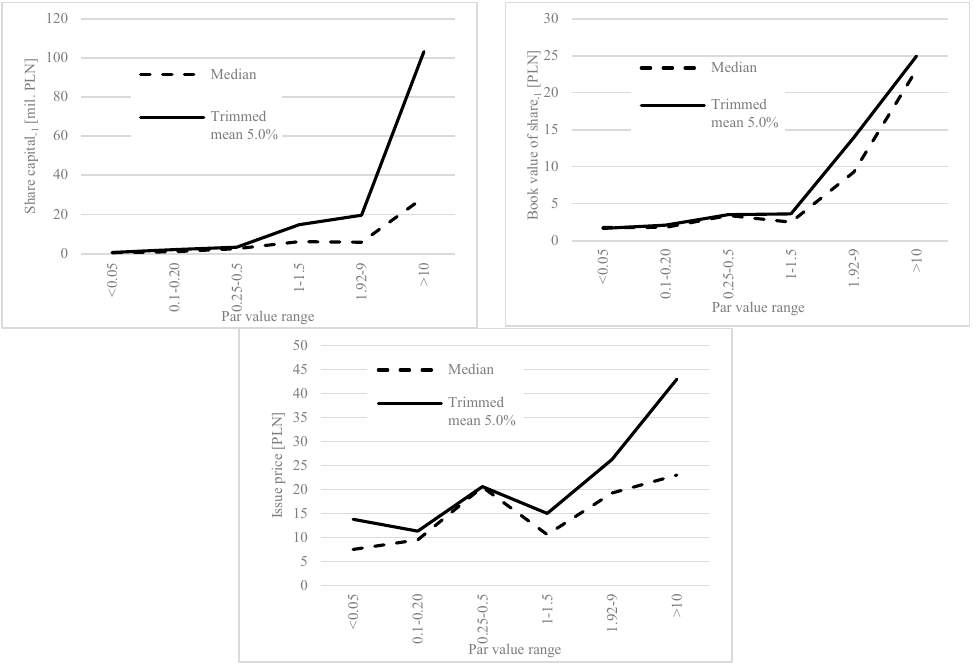
Figure 3. First-degree financing parameters depending on PaV. Table 7. Regression analysis of the determinants of first-degree financing parameters.